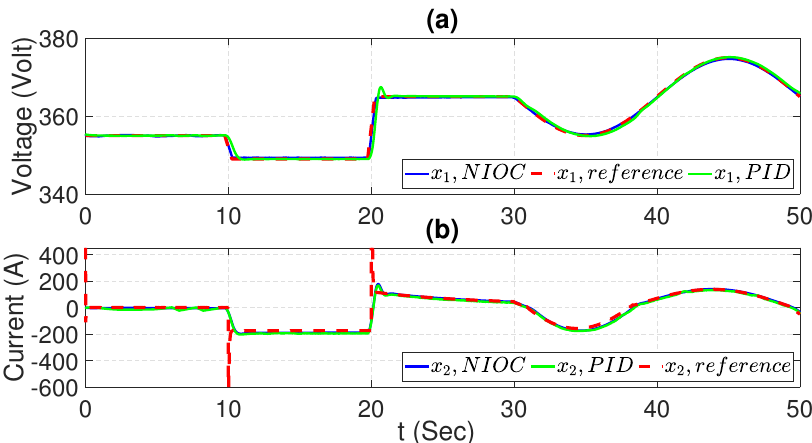
Figure 12. Influence of L changes on PI and NIOC: ( a ) voltage, ( b ) current.